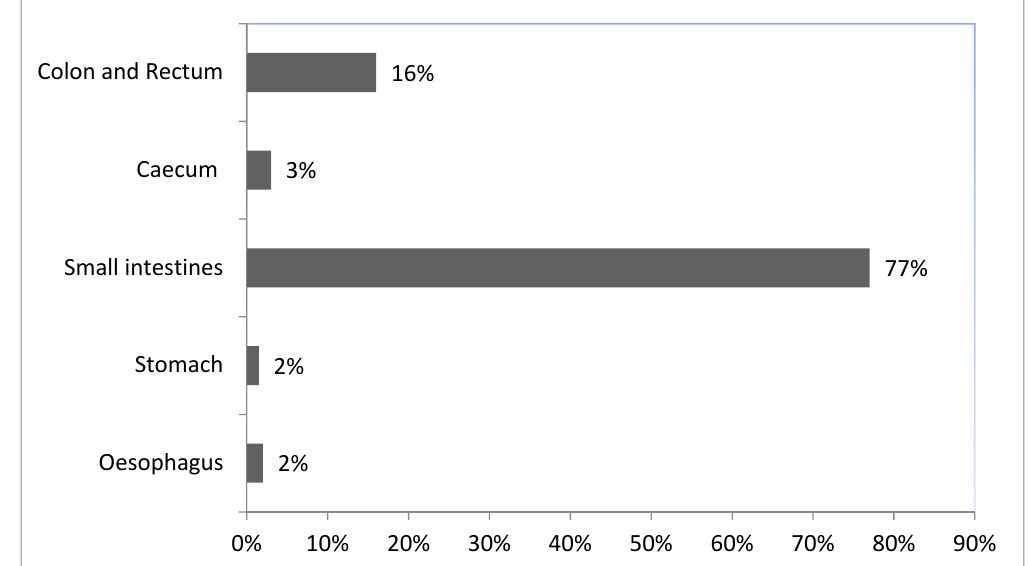
Figure 5. Relative length (%) of the gastrointestinal tract of the agouti.